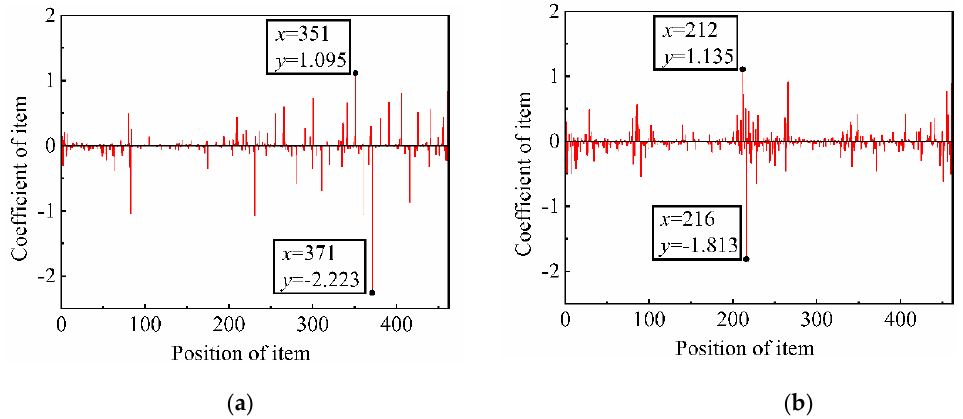
Figure 9. The variation in prediction error with iteration steps: ( a ) total pressure training error; ( b ) efficiency training error.